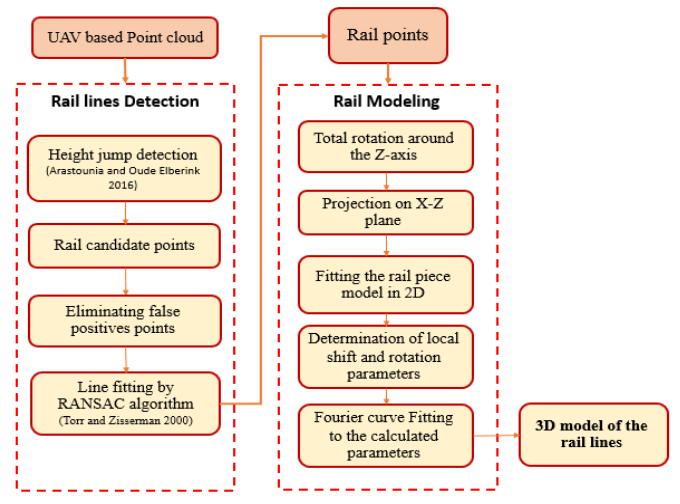
Figure 1. Flowchart of the proposed method.